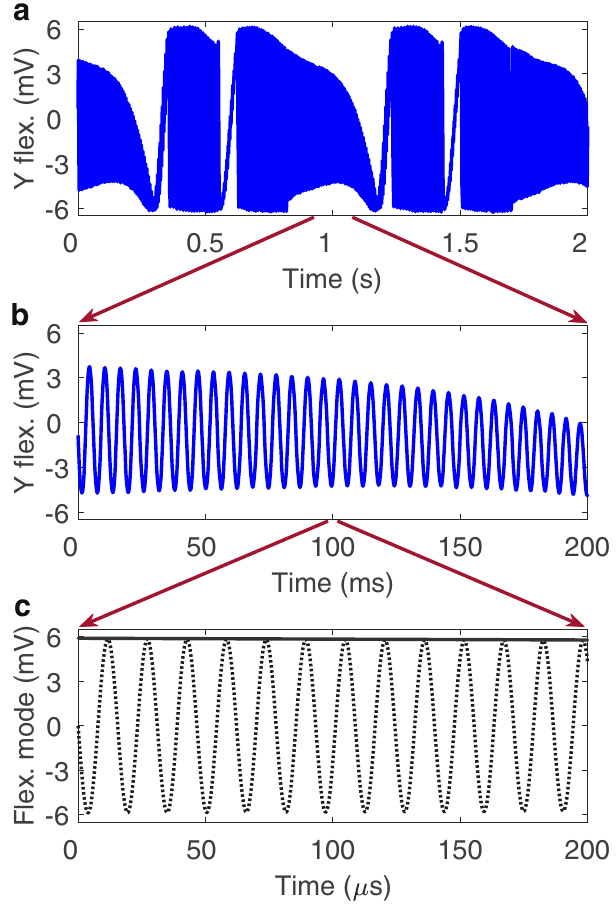
Fig. 2 | Resonatordynamicsonthree different timescalesof the fl exuralmode. Red arrows indicate how the data is displayed at shorter and shorter timescales for subsequent plots. a Measured slow evolution of the y amplitude quadrature intheresonatorresponse(i.e.,afterdown-modulationwiththedrivefrequency) showing the repetition of long-term robust responses. The dynamics on this timescale are determined primarily by the dissipation rates of each mode ~1 s. b Measured intermediate timescale i.e., zoom-in of ( a ); the modulations of the down-modulated y amplitude quadrature of the resonator response showing dynamics on a timescale ~10ms determined primarily by the detuning of the fl exural mode from its natural frequency. c Amplitude mode (solid) and the fast resonator response showing oscillations (dashed) at the timescale of the drive period ~10 μ s (i.e., before the signal is down-